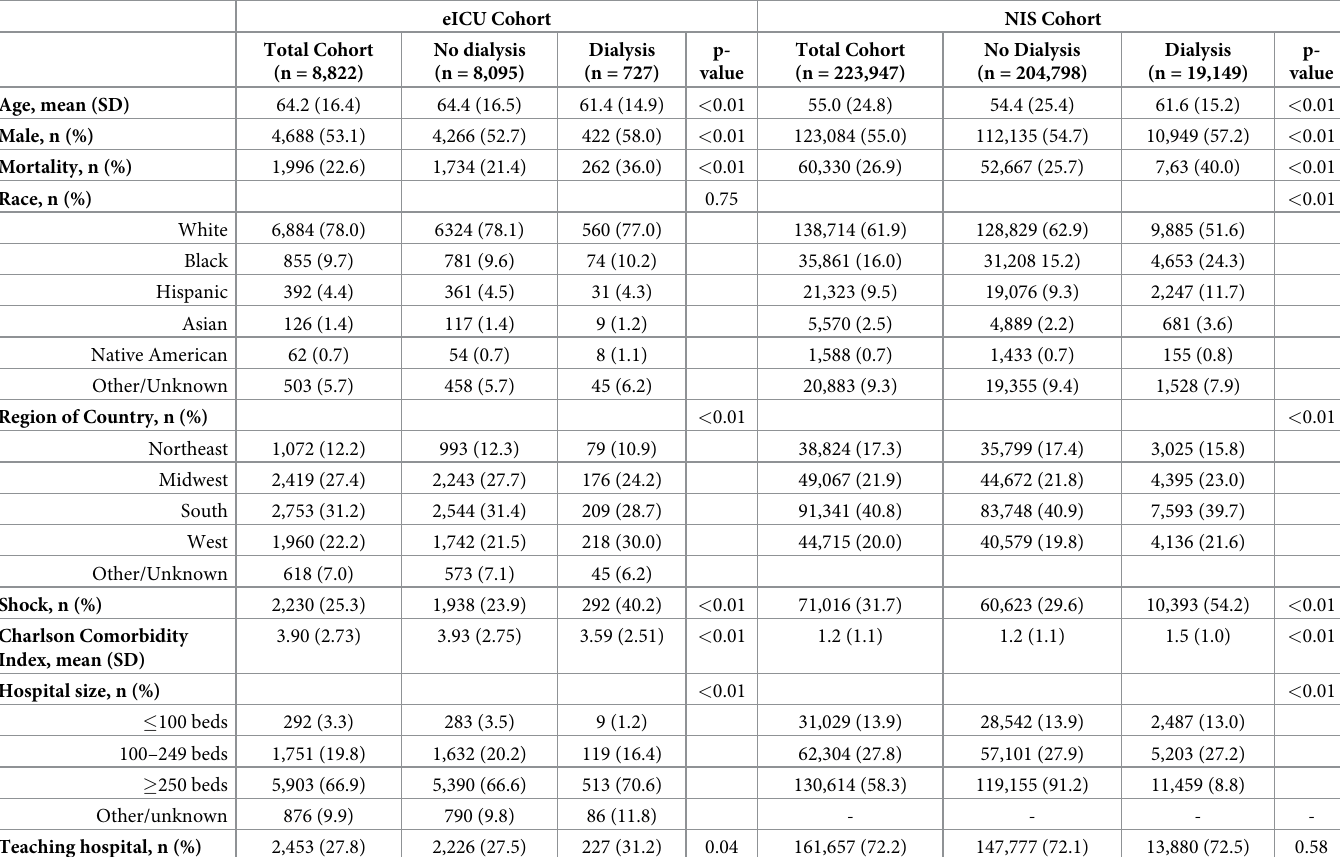
Table 1. The baseline characteristics of the patients in the eICU and NIS cohorts. The patients receiving dialysis and those not receiving dialysis from each cohort are compared using the Student’s independent t-test of Wilcoxon Rank Sum test for continuous variables, and the Chi-Square test for categorical